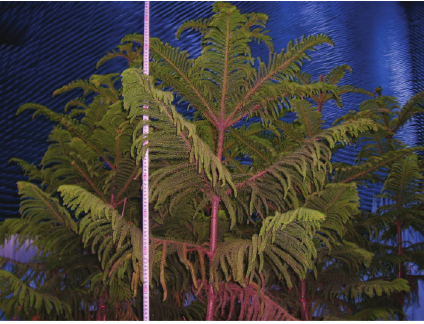
Figure 3: The small fir